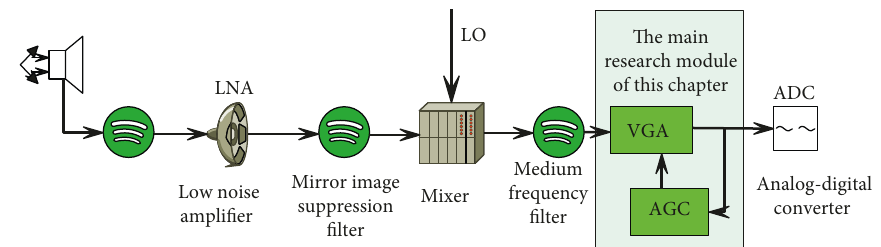
Figure 1: Wireless receiver system structure.